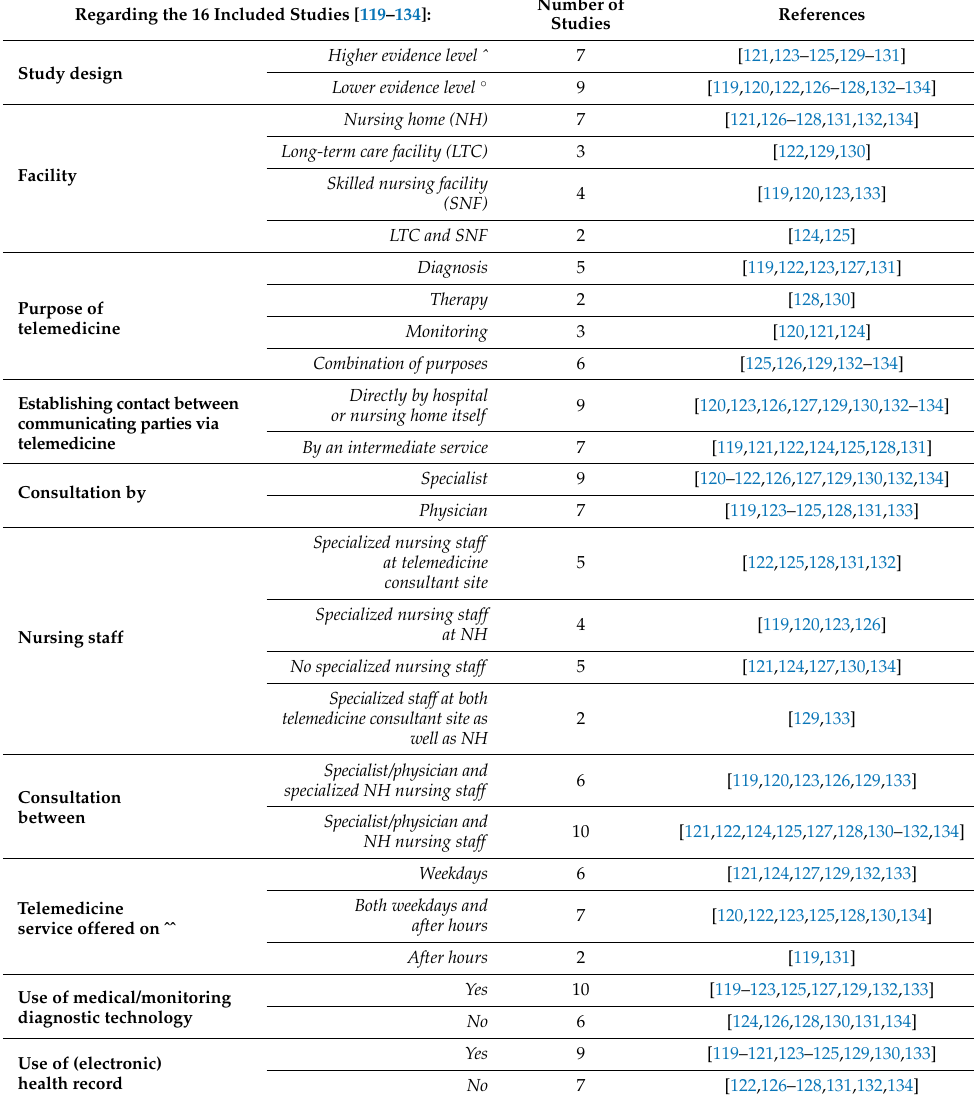
Table 3. Study and intervention descriptors of the 16 included